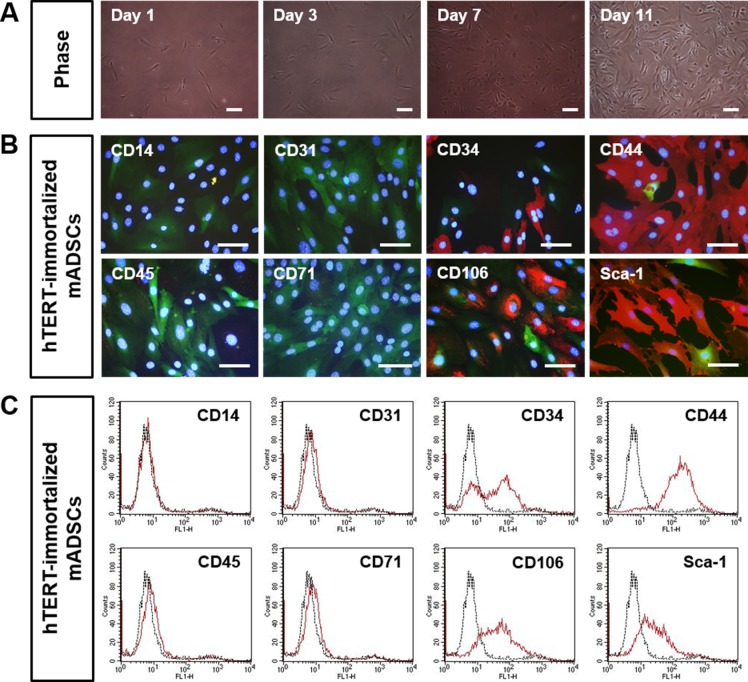
Phenotypic characterization of hTERT-immortalized mADSCs.Primary mADSCs were infected with a retroviral vector harboring hTERT-IRES-EGFP, and selected for about 3 months with puromycin. (A) Morphology of hTERT-immortalized mADSCs. Morphological properties of hTERT-immortalized mADSCs were analyzed at 1, 3, 7, and 11 days after initiation of cultures. (B) hTERT-immortalized mADSCs were stained with primary antibodies against CD14, CD31, CD34, CD44, CD45, CD71, CD106, and Sca-1, and were visualized with Alexa Fluor-594 conjugated anti-rat antibodies (red). Nuclei were stained with DAPI. Immunofluorescence staining of hTERT-immortalized mADSCs shows positive expression for CD34, CD44, CD106, and Sca-1. Scale bars = 100 μm. (C) Flow cytometric analysis of hTERT-immortalized mADSCs shows positive expression for CD34, CD44, CD106, and Sca-1. Scale bars in A and B = 100 μm.